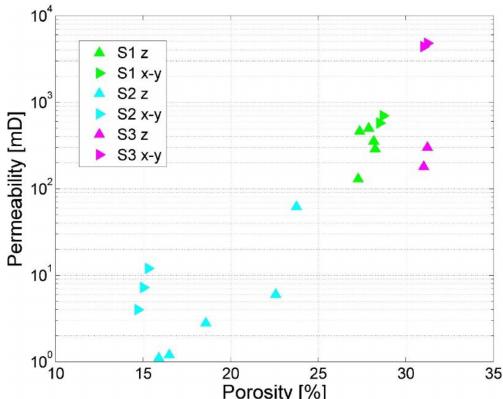
Figure 8. Results of porosity–permeability lab measurements. The permeability of the samples was measured in directions perpendic- ular to the bedding ( z direction) and parallel to the bedding ( x – y